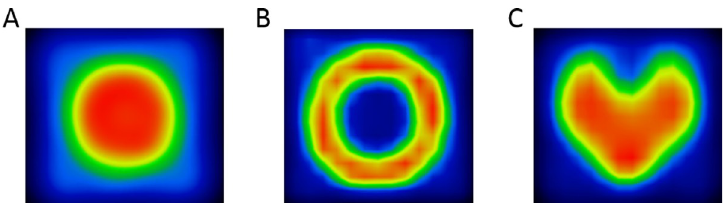
Fig 3. Demonstrative axial slices of 3 dimensional images : hot sphere (A), spherical shell (B), heart